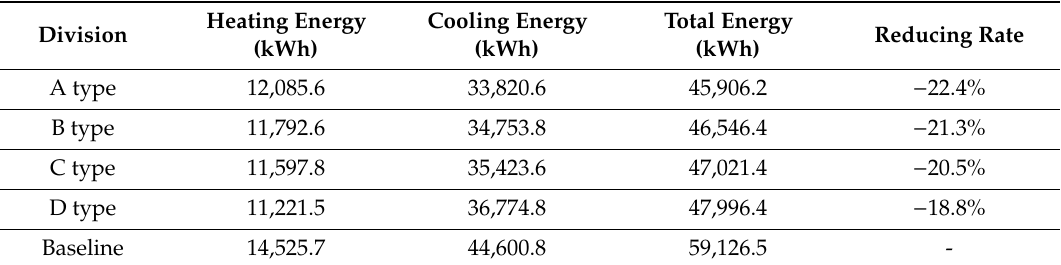
Table 16. Annual building energy analysis result by attached PDLC window remodeling.